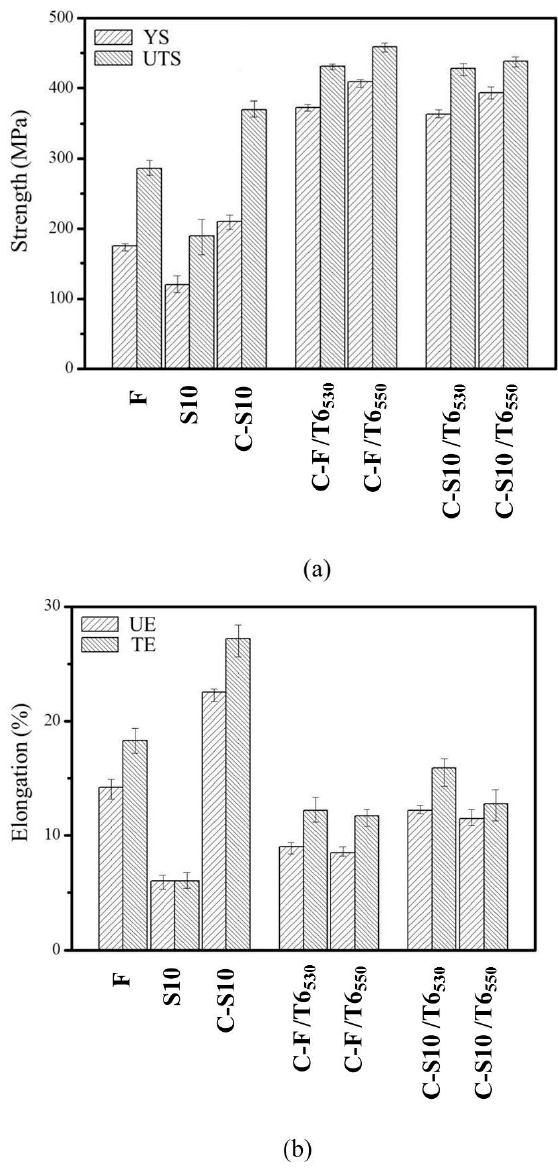
Figure 11. Mechanical properties of specimens: ( a ) tensile strength and ( b ) tensile elongation.